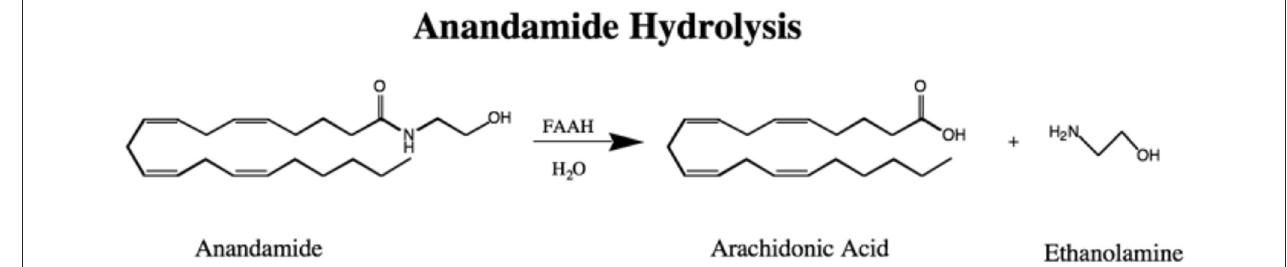
FIGURE 1 | The Hydrolysis of Anandamide to Arachidonic Acid and Ethanolamine by FAAH.